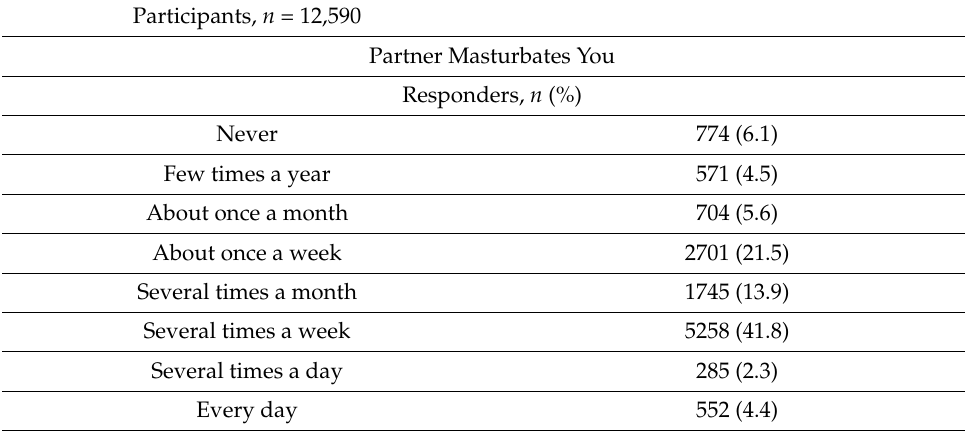
Table 2. Sexual experience patterns in the total